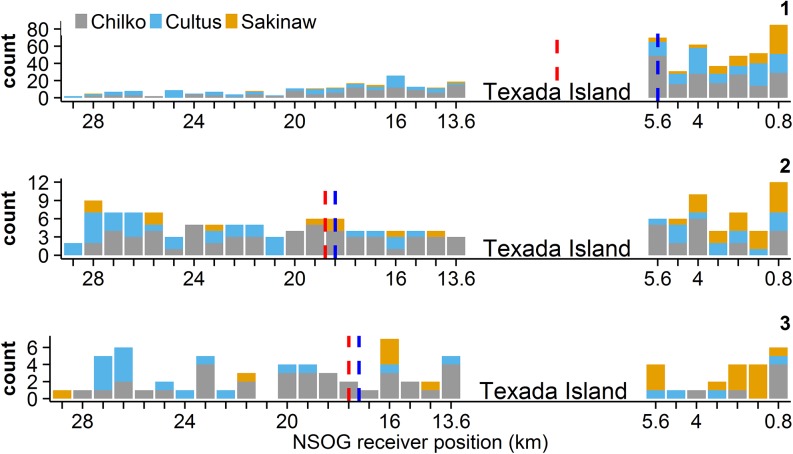
The distribution of sockeye salmon smolts on the northern Strait of Georgia (NSOG) array for the first (1), second (2) and third (3) detection sequences.Stacked colors indicate populations. Receiver positions represent those shown in the inset of Fig 1, and the gap between receivers 7 (5.6 km) and 8 (13.6 km) indicate the position and relative width of Texada Island. Dashed vertical lines indicate the mean (red) and median (blue) positions of sockeye smolts for each detection sequence. Note that the mean position of the first detection sequence was directly between Malaspina Strait (receiver positions 1–7) and Strait of Georgia (receiver positions 8–27).